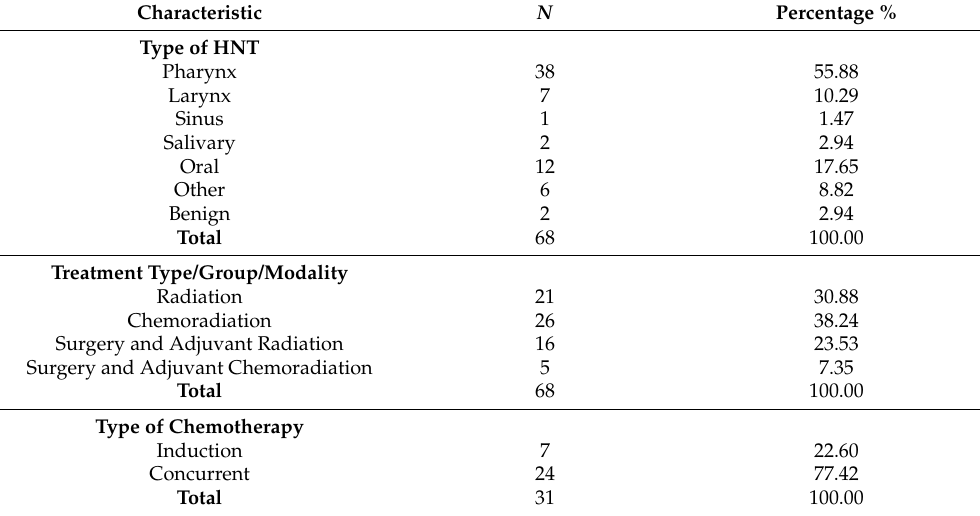
Table 1. Relevant characteristics of the